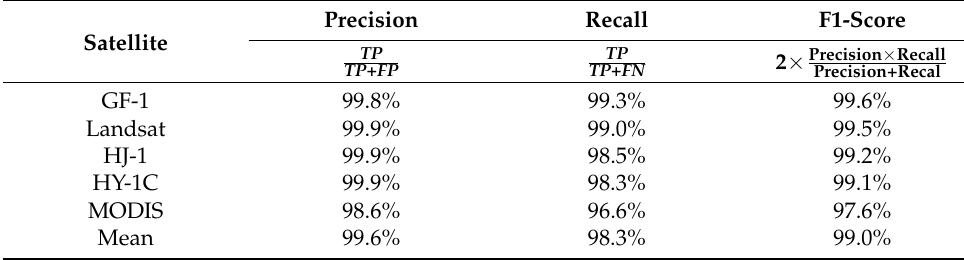
Table 4. Accuracy evaluation of the extraction effect.